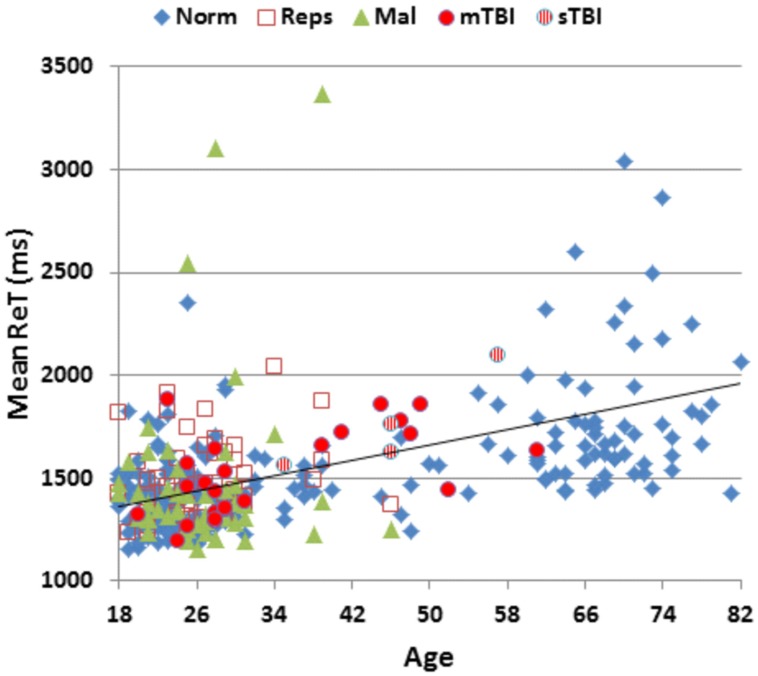
Mean response times (ReTs) as a function of age. ReTs were averaged over different list positions. See Figure 2 for group membership specifications.